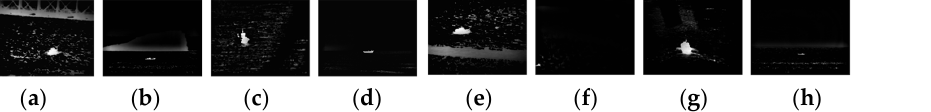
Figure 17. ( a – h ) is preprocessed results of images in Figure 16a–h, respectively. Table 2. SCRG value after image